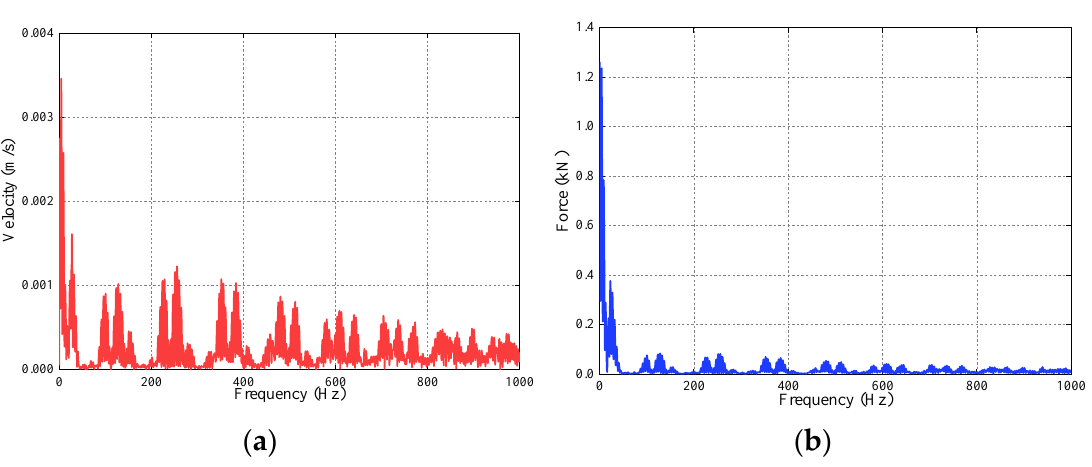
Figure 3. The frequency-domain ( a ) velocity and ( b ) force results. Figure 5. The frequency-domain ( a ) velocity and ( b ) force